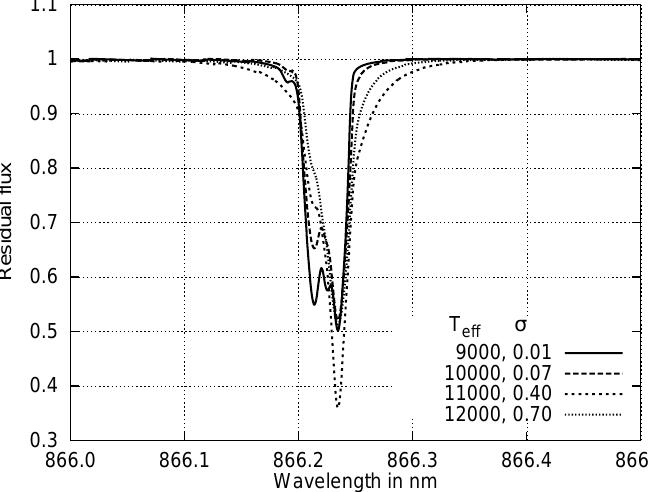
Fig. 6. The same as in Fig. 5, but for the Ca II triplet component at 866.2 nm. manganese stars of late B and early A spectral